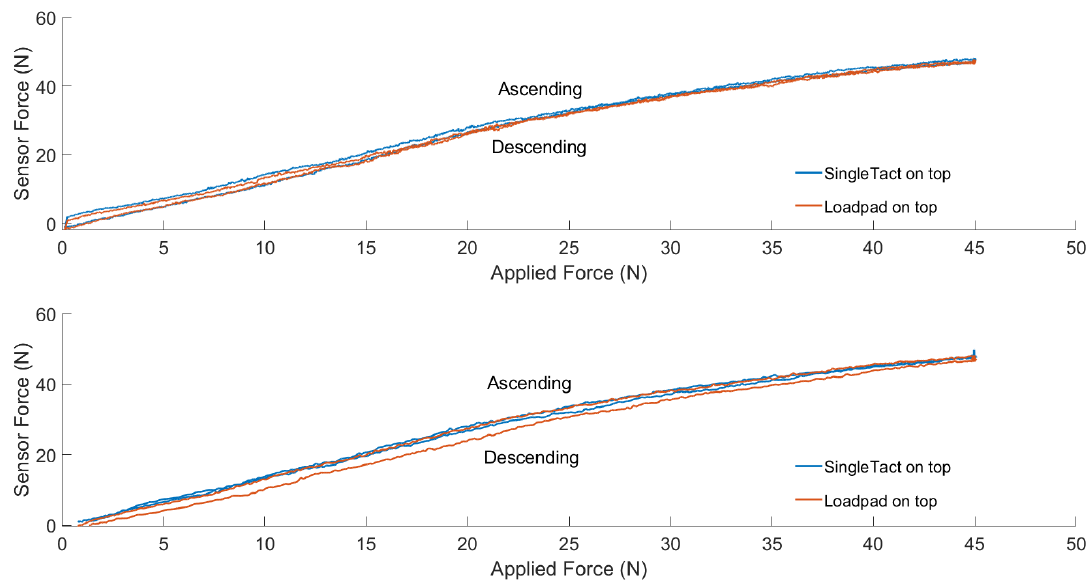
Figure 6. Hysteresis of the SingleTact and the Loadpad sensors at two different loading rates and stacking order.